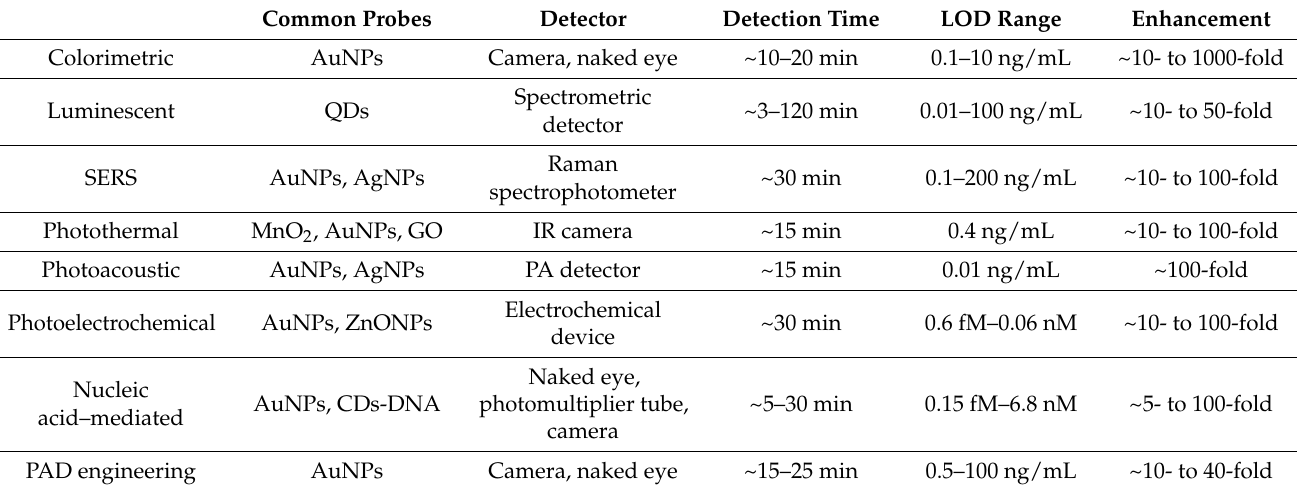
Table 1. Performance comparison of different signal amplification strategies for improving sensitivity of PADs. Common